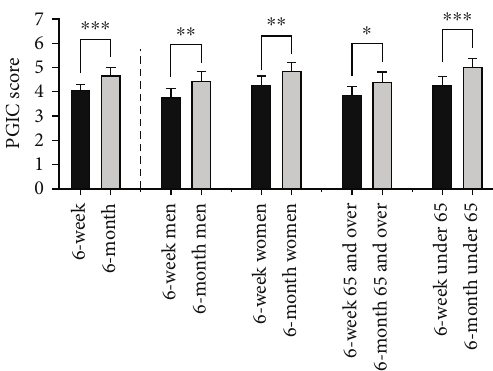
Figure 1: VAS scores at baseline and at six months postprocedure. The VAS scores were signi fi cantly improved at 6 months as compared to baseline in the total patient population (left columns). When broken into subgroups (men, women, patients < 65 , and patients ≥ 65 ), all subgroups showed signi fi cant improvement as well ( ∗∗∗ p ≤ 0 : 0001 ).